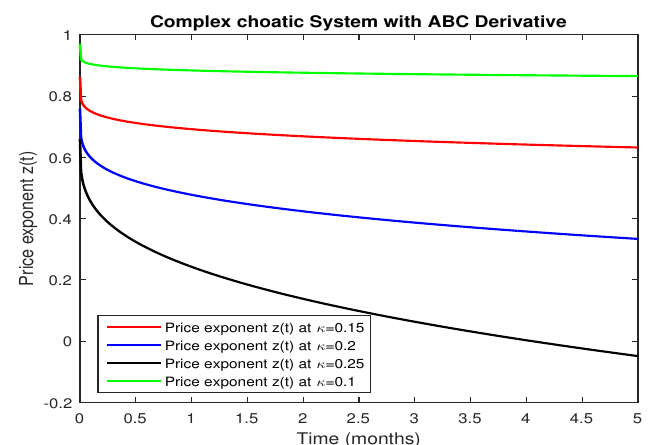
Figure 5. y ( t ) investment demand with ABC derivative.